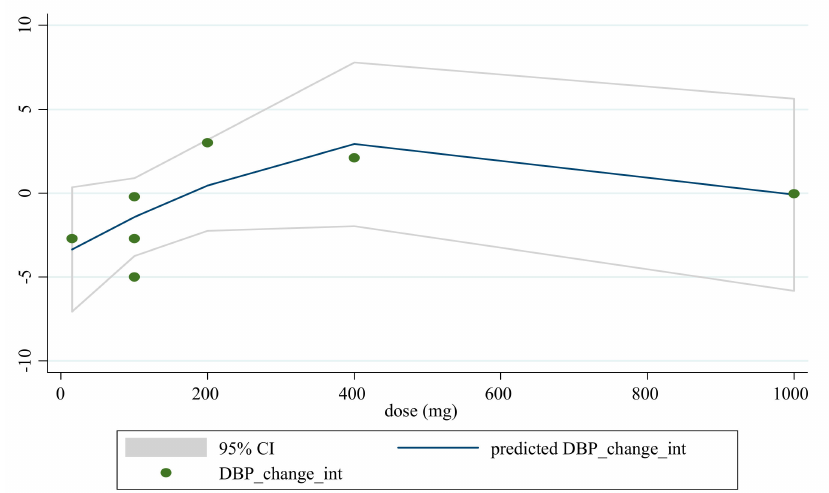
Figure 6. Non-linear dose-response relationships between saffron supplementation and absolute mean differences. Dose-response relationships between the saffron dosage and absolute mean differences in DBP.